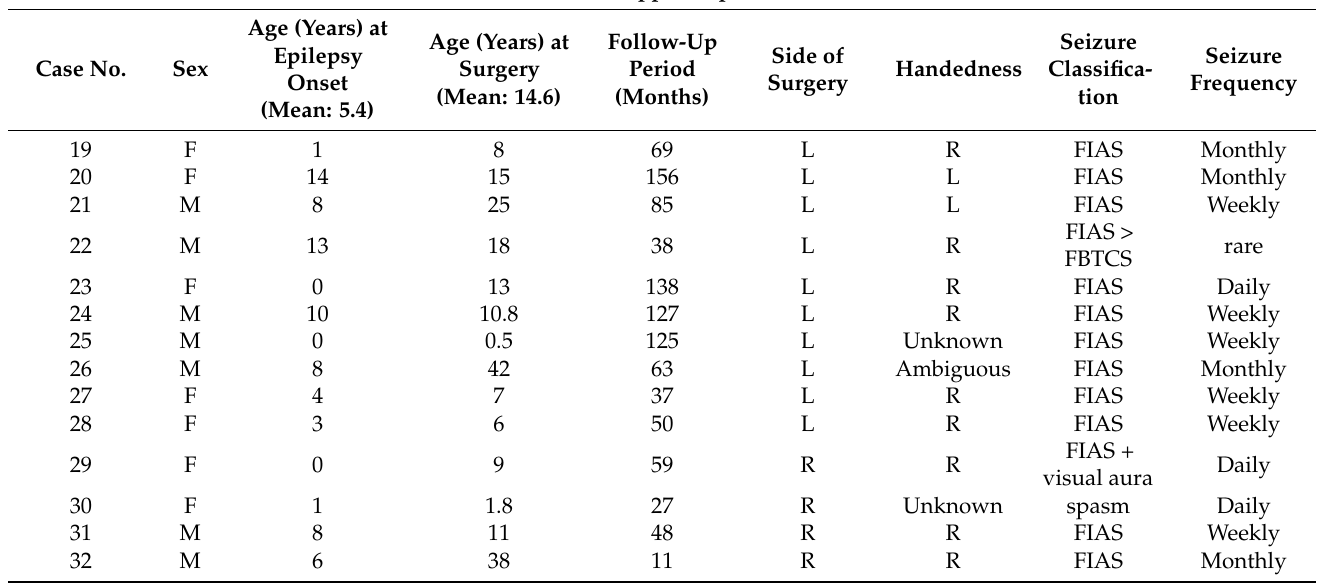
The tumors were in the left temporal lobe and medial to the collateral sulcus in 20 (62.5%) and 18 (56.3%) patients, respectively (Figure 1). Cystic formation and calcification were seen in 22 (68.8%) and 13 (40.6%) tumors, respectively. The pathological diagnosis was ganglioglioma in 15 patients (45.6%), low-grade glioma or astrocytoma in 15 patients, glioneuronal tumor in 1 patient, and dysembryoplastic neuroepithelial tumor in 1 patient (Table